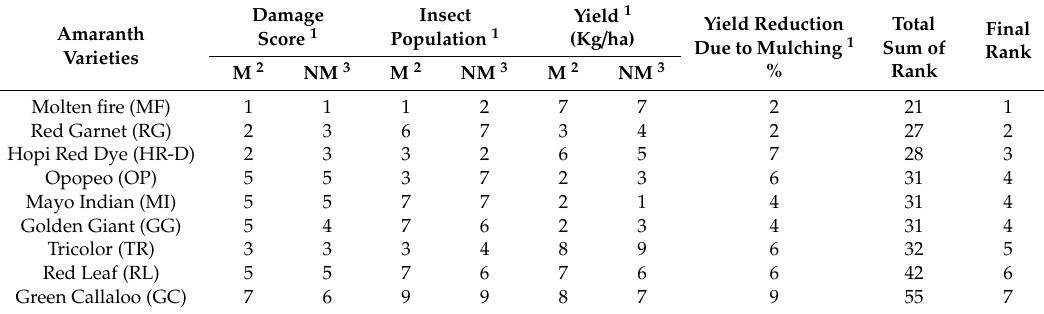
Table 6. Ranking of Amaranth Varieties based on Agronomic